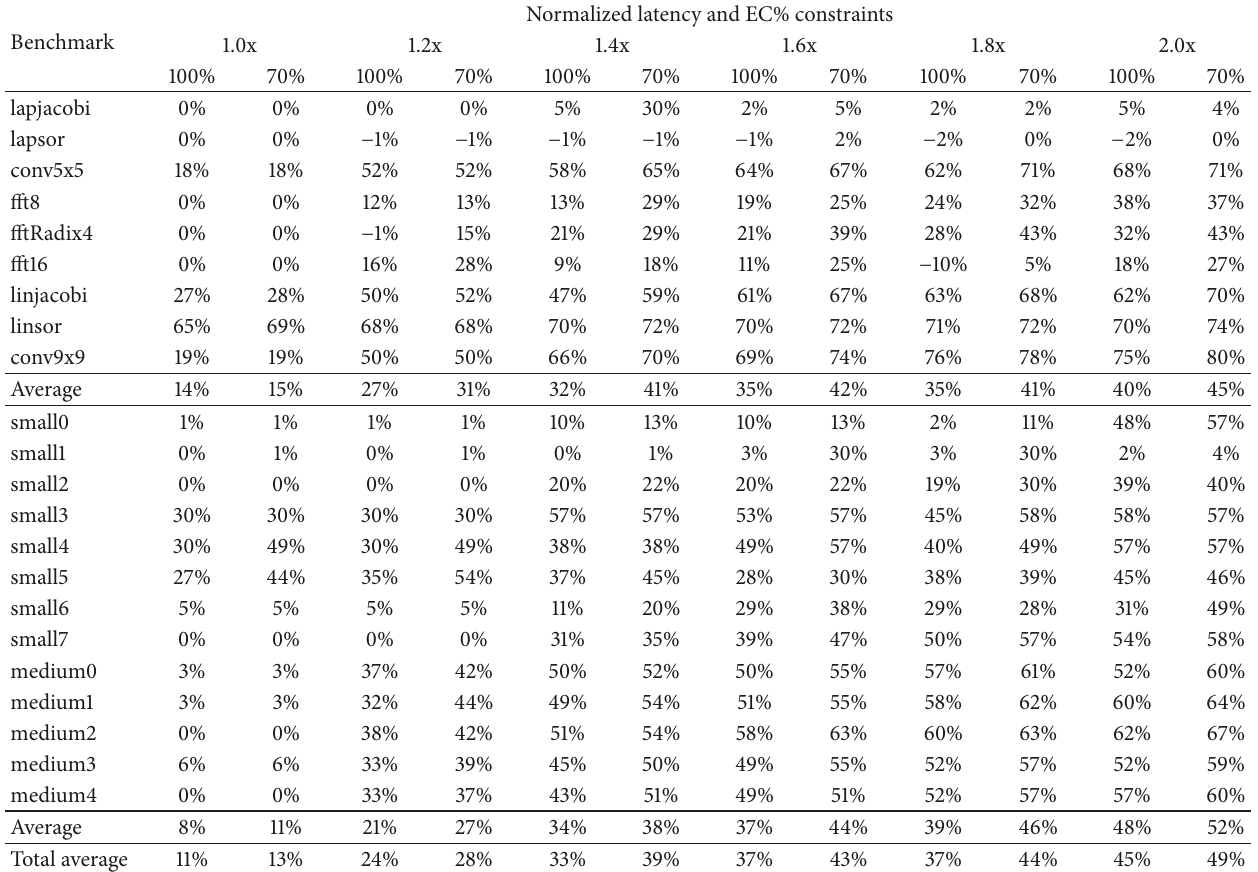
Table 2: Resource savings (LUT%) of FD-FTA heuristic compared to TMR-RTL for 100% and 70% EC. Benchmark